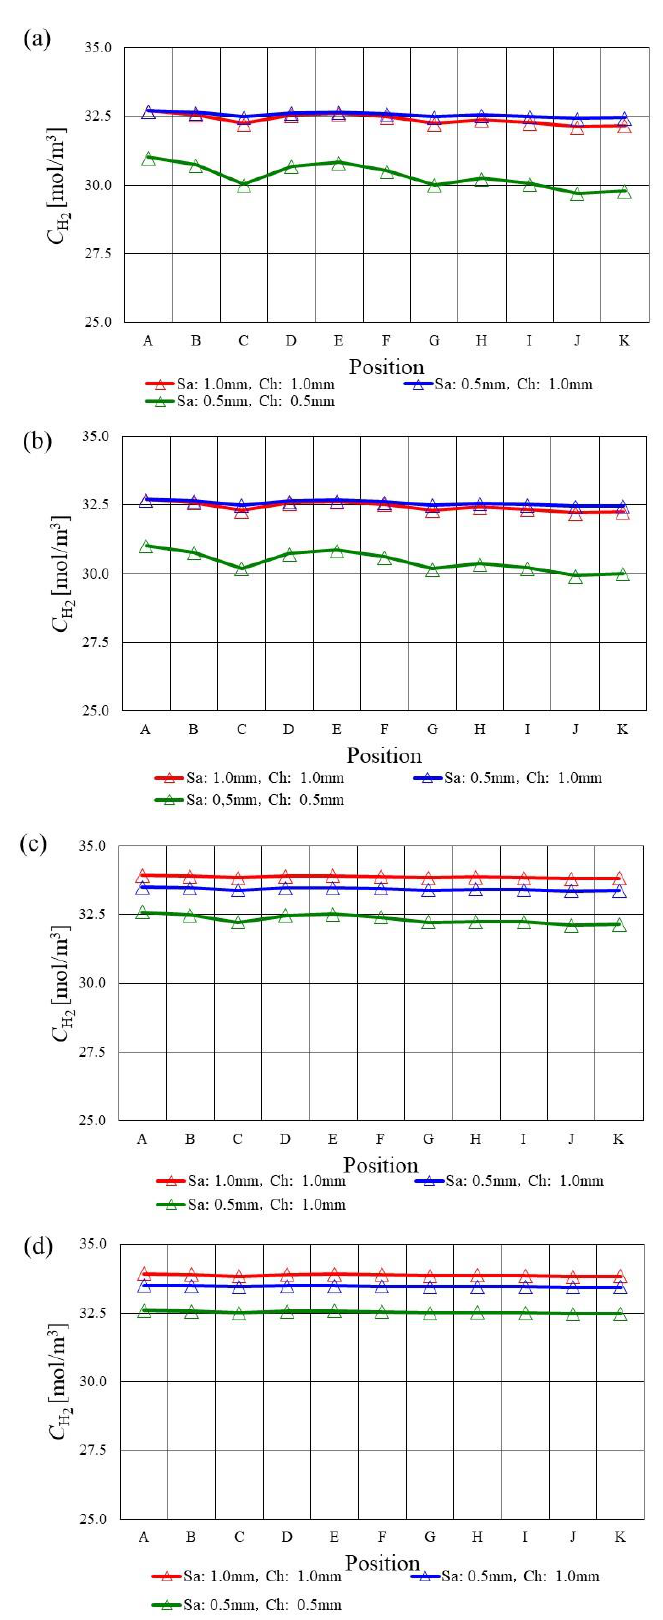
Figure 3. Molar concentration of H 2 along with the gas channel on the interface between PEM and catalyst layer at the anode among various s.t. at T ini = 363 K. ( a ) A80%RH/C80%RH, ( b ) A80%RH/C40%RH, ( c ) A40%RH/C80%RH, ( d )